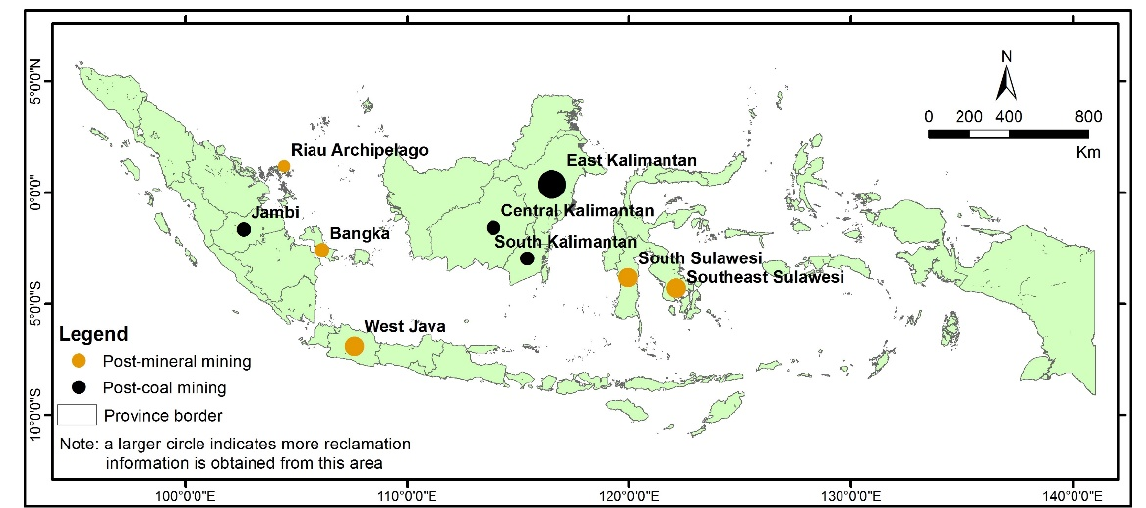
Figure 1. Some post-mining areas focused on in this study.